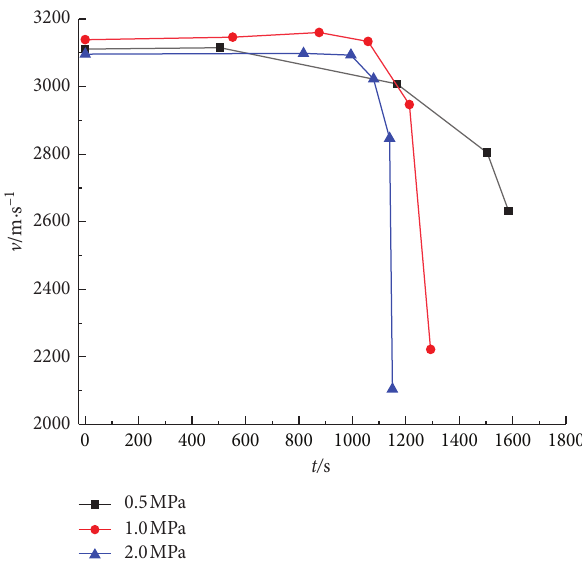
Figure 16: Variation of AW velocity at different unloading